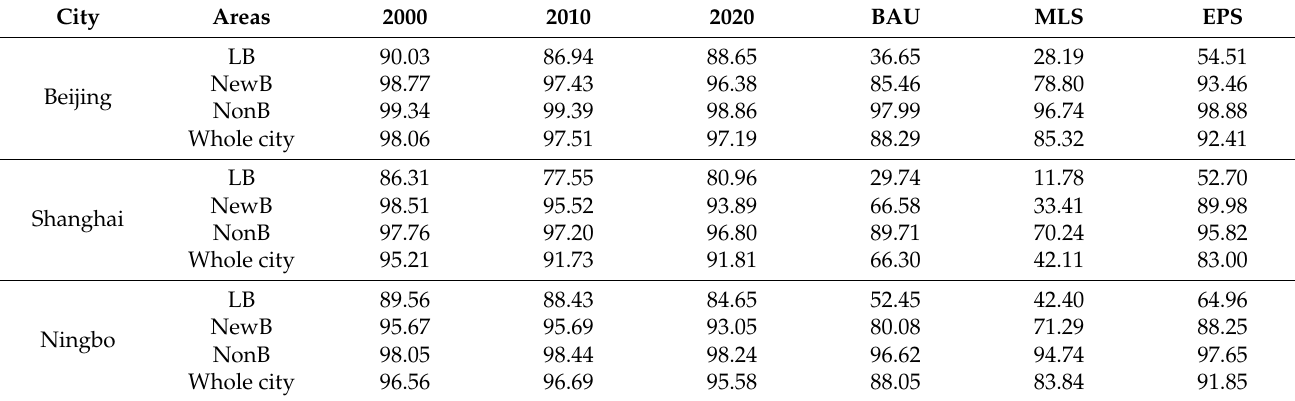
Table A5. Statistics of the GIC in different areas of each city from 2000 to